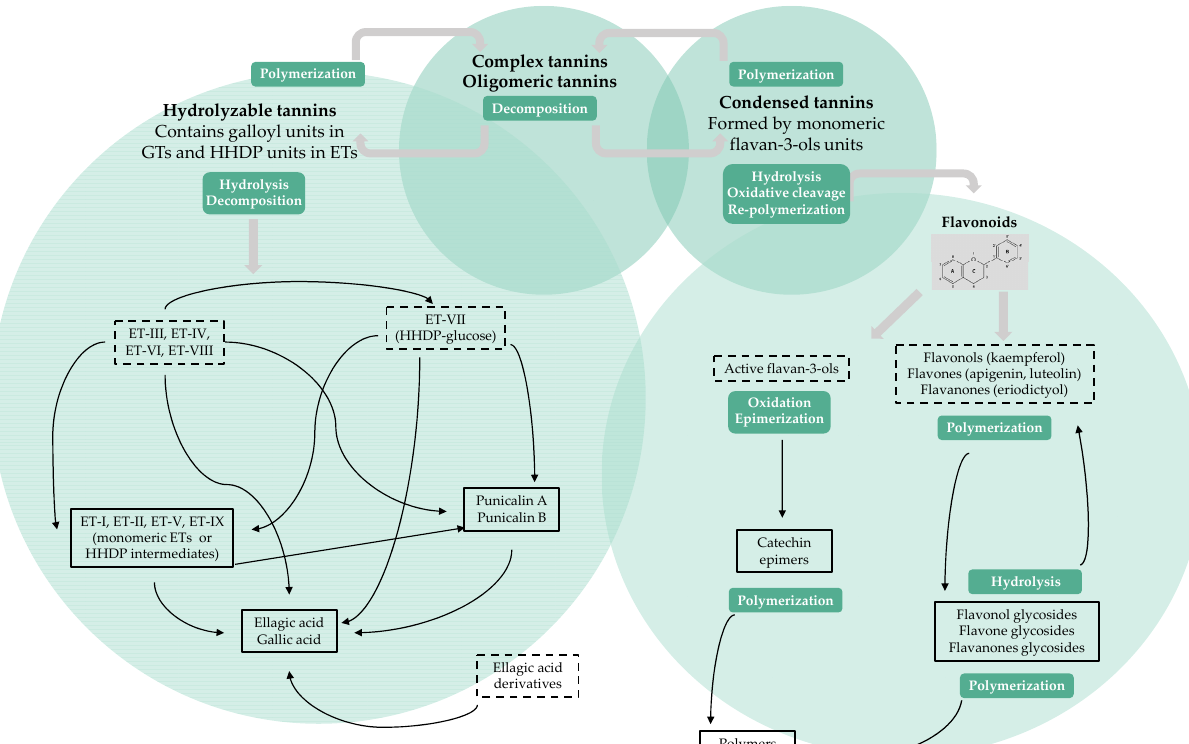
Figure 2. The hypothesized transformation action of the determined polyphenolic composition and the putative compounds of pomegranate leaf infusion during one-day storage. The relevant compounds were classified into hydrolyzable tannins (HTs), condensed tannins (CTs), flavonoids, and complex or oligomeric tannins. Polyphenolic compounds enclosed in dashed (or solid) boxes indicated decreased (or increased) concentrations. Reactions enclosed in green rounded rectangles indicated the possible transformation mechanisms between the compounds.